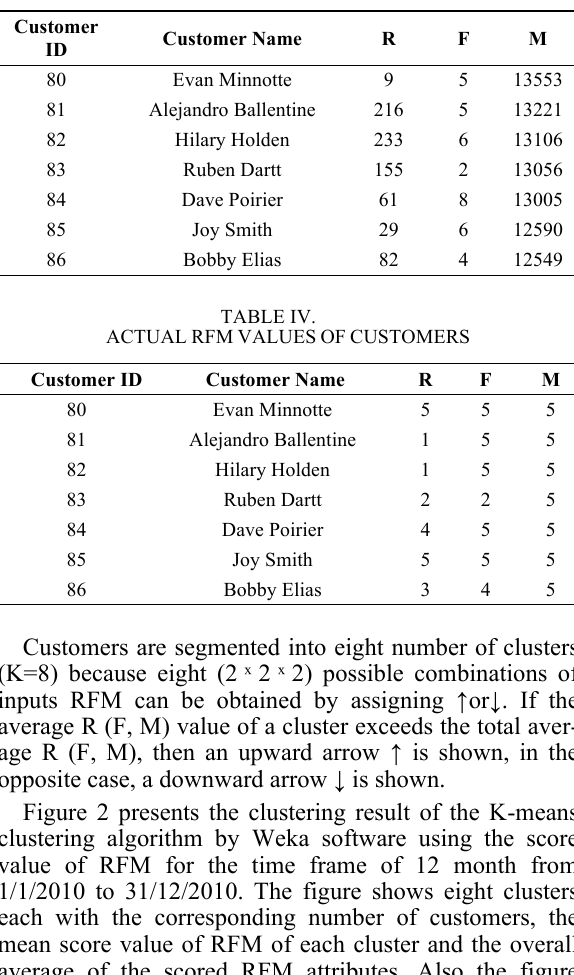
TABLE III. SCORED RFM VALUES OF CUSTOMERS